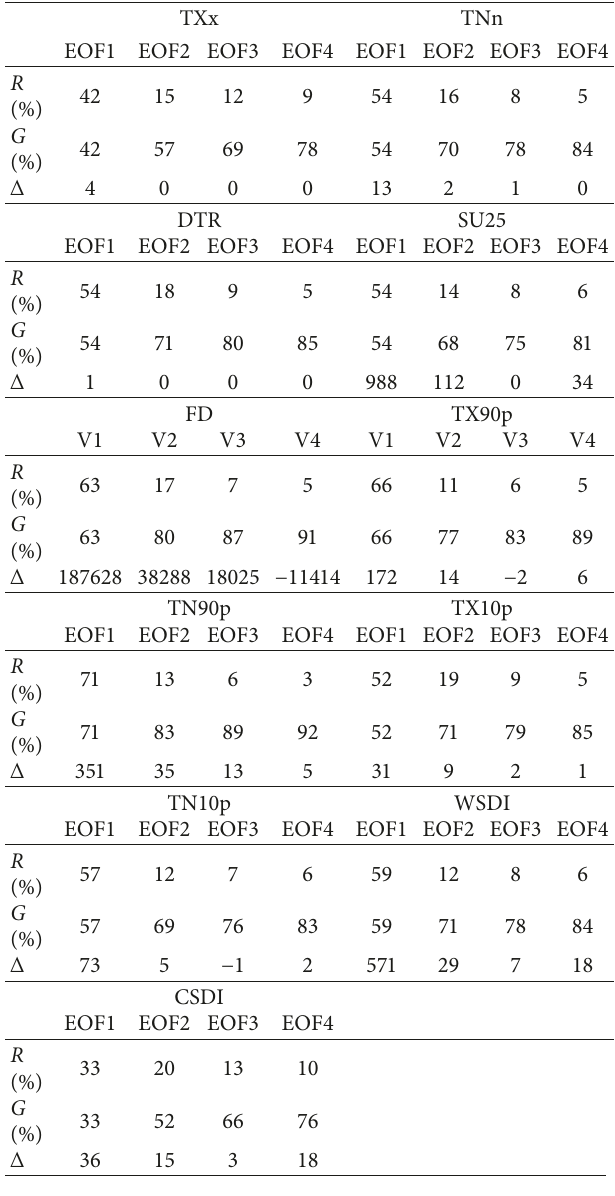
Table 4: Variance contribution rate and North significance test results of the first four modes of extreme temperature